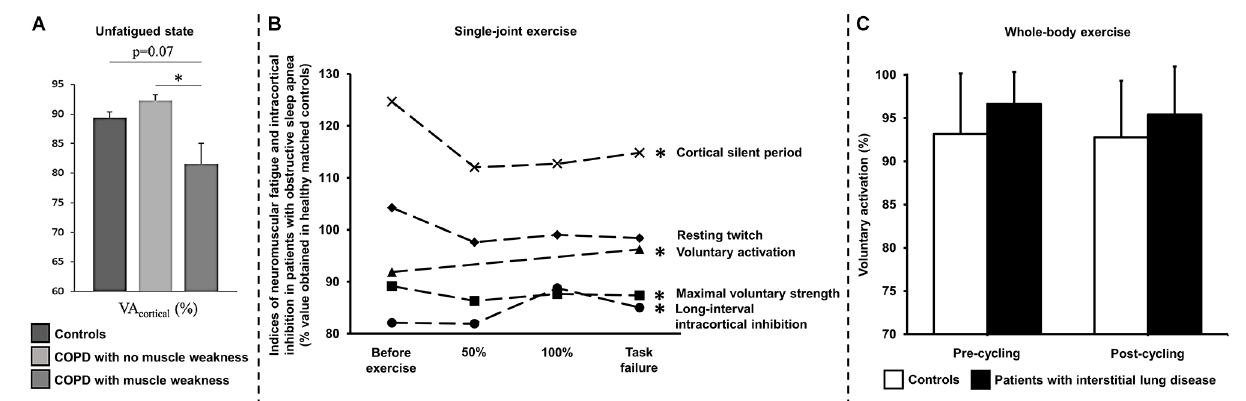
FIGURE 3 | Assessment of neuromuscular fatigue by peripheral nerve and transcranial magnetic stimulations in chronic cardiorespiratory disorders using various exercise modalities. (A) Deficits in voluntary activation of the unfatigued (i.e., with no prior fatiguing exercise) knee extensors by transcranial magnetic stimulation has been demonstrated in patients with chronic obstructive pulmonary disease (COPD) showing peripheral muscle weakness in comparison to their counterparts with no muscle weakness. * p < 0.05: patients with vs. with no peripheral muscle weakness. Reproduced and modified, with the permission of the publisher from: Alexandre et al. (2020). (B) Lower maximal voluntary strength and voluntary activation by transcranial magnetic stimulation of the knee extensors but similar resting twitch have been shown in patients with severe obstructive sleep apnea syndrome throughout single-joint exercise (repeated knee extensions to task failure, starting at 35% of maximal voluntary strength) in comparison to healthy controls. Greater magnitude (long-interval intra-cortical inhibition) and duration (cortical silent period) of intra-cortical inhibition have also been reported using transcranial magnetic stimulation in these patients compared to their healthy counterparts. * Indicates a significant difference for a given parameter throughout exercise between patients with obstructive sleep apnea using healthy controls as a reference ( p < 0.05). Data obtained before and after treatment by continuous positive airway pressure were pooled since the intervention did not improve cortical impairments in patients. 50% and 100% refer to data obtained at 50% and 100% of the duration of the shortest test i.e., before or after treatment by continuous positive airway pressure. Reproduced and modified, with the permission of the publisher from: Marillier et al. (2018a). (C) Voluntary activation measured using the twitch interpolation technique in response to magnetic stimulation of the femoral nerve in controls and in patients with fibrotic interstitial lung disease before and after a constant-load (60% peak work rate) exercise test to symptom limitation under medical air. Voluntary activation did not significantly differ between controls and patients, being unaltered by exercise in both groups, despite severe exertional hypoxemia in patients. Voluntary activation was assessed ∼ 3 min after whole-body exercise in these subjects. Time delay between exercise cessation and fatigue assessment is a limitation to capture central fatigue after whole-body exercise. Similar observations have been made in patients with heart failure (Hopkinson et al., 2013). Reproduced and modified, with the permission of the publisher from: Marillier et al.